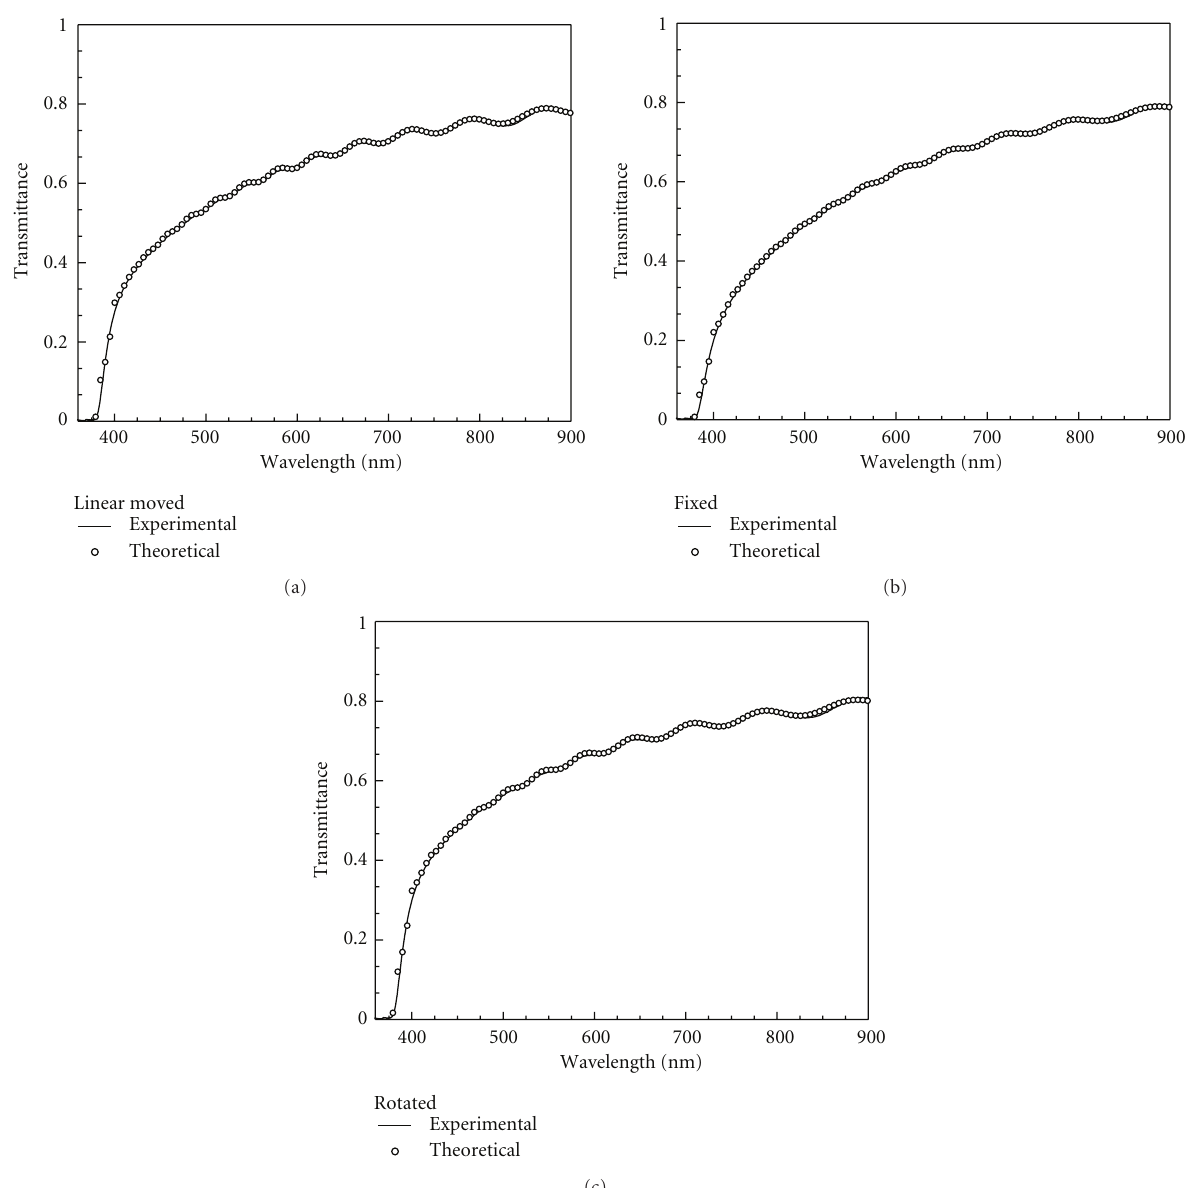
Figure 1: Experimental optical transmission spectra (solid line) of ZnO thin films: (a) on the linear moved substrate at the horizontal axis, (b) on the fixed substrate, and (c) on the rotated substrate in the horizontal plane. Also the theoretical optical transmission spectra (“o” symbol) are shown for